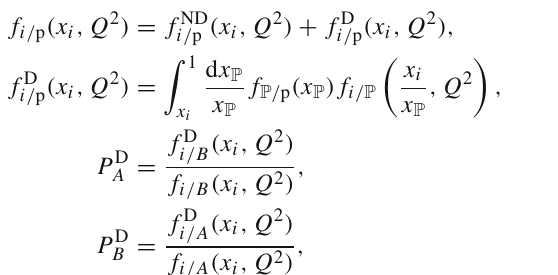
Fig. 2 The photon fluxes used for different beam types. Here f γ/ b is the photon flux obtained from the beam